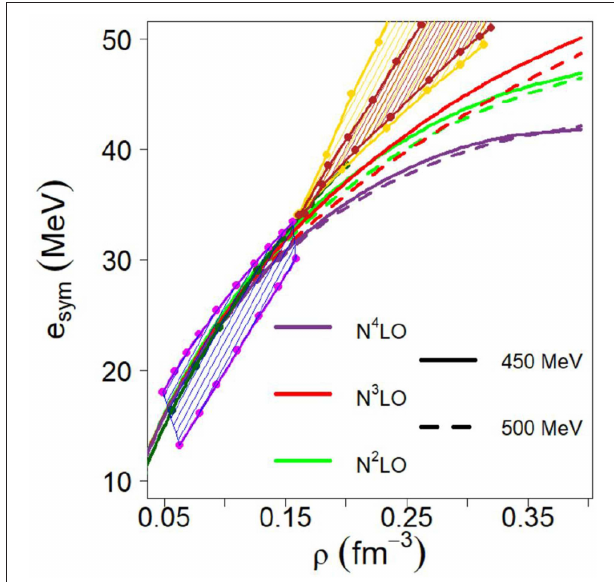
FIGURE 8 | The symmetry energy vs. density. The curves are obtained from the various microscopic EoS for NM at the indicated chiral orders and cutoff values, combined with the phenomenological EoS for SNM [ 135] as explained in the text. The additional predictions and various constraints are from: Danielewicz and Lee [ 136], dark green; Tsang et al. [137], magenta contour; Russotto et al. [ 138, 139], yellow and brown shaded areas. (The data points were extracted from the graphs assuming ρ 0 = 0.16 fm − 3 and using WebPlotDigitizer opensource software, https://automeris.io/WebPlotDigitizer).